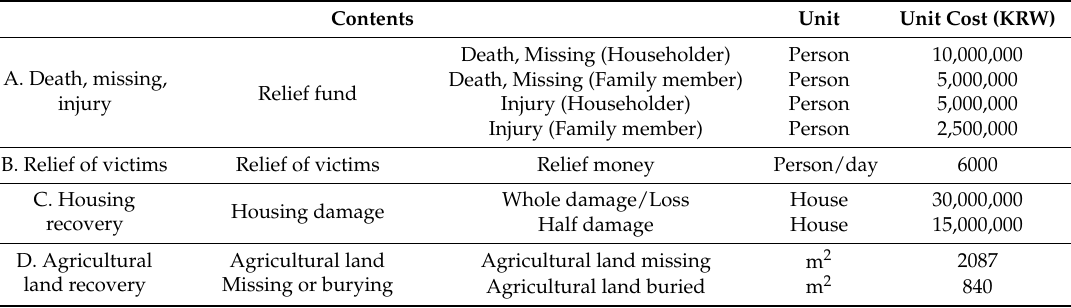
Table 5. Application contents of natural disaster recovery guideline.